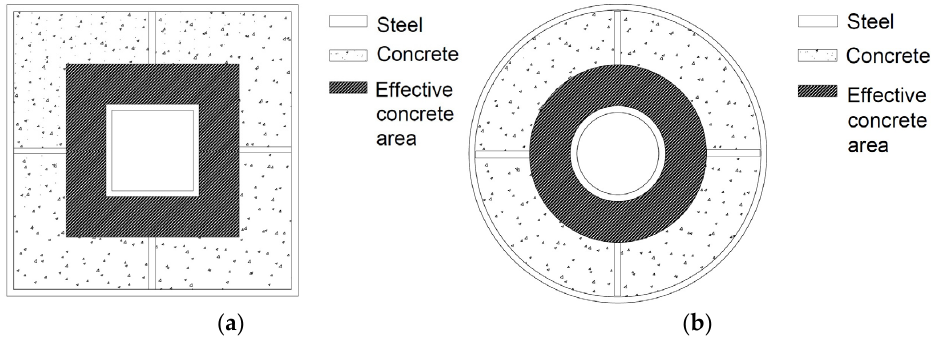
Figure 2. The effective cross-section area of the concrete in a stiffened CFDST column. ( a ) Square column. ( b ) Circular column.